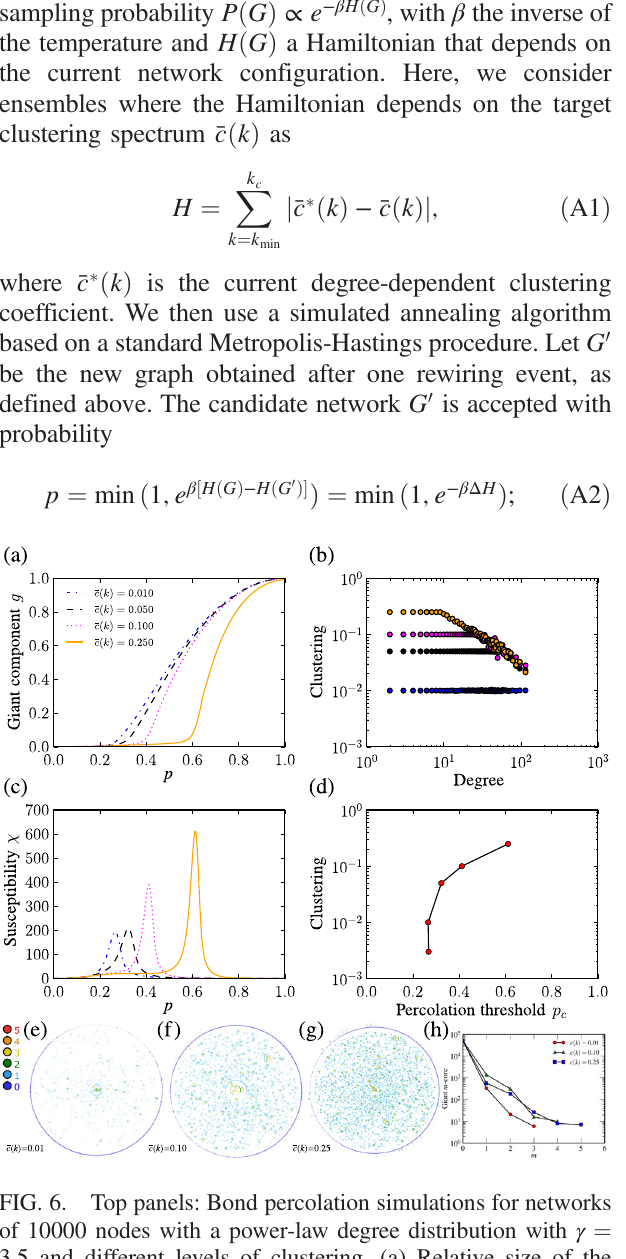
FIG. 7. Top panels: Bond percolation simulations for networks of 10000 with a power-law degree distribution with γ ¼ 4 and different levels of clustering. (a) Relative size of the largest connected component g as a function of the bond occupation probability p . (b) Degree-dependent clustering coefficient ¯ c ð k Þ . (c) Susceptibility χ as a function of bond occupation probability ) as a max p . (d) Percolation threshold ( p ) as a function of the level of max clustering. Bottom panels: (e – g) m -core decomposition of three different networks of 50000 nodes, γ ¼ 4 , and different levels of clustering, ¯ c ð k Þ ¼ 0 . 01 , 0.05, 0.25. (h) Size of the largest connected component of the m -core as a function of m